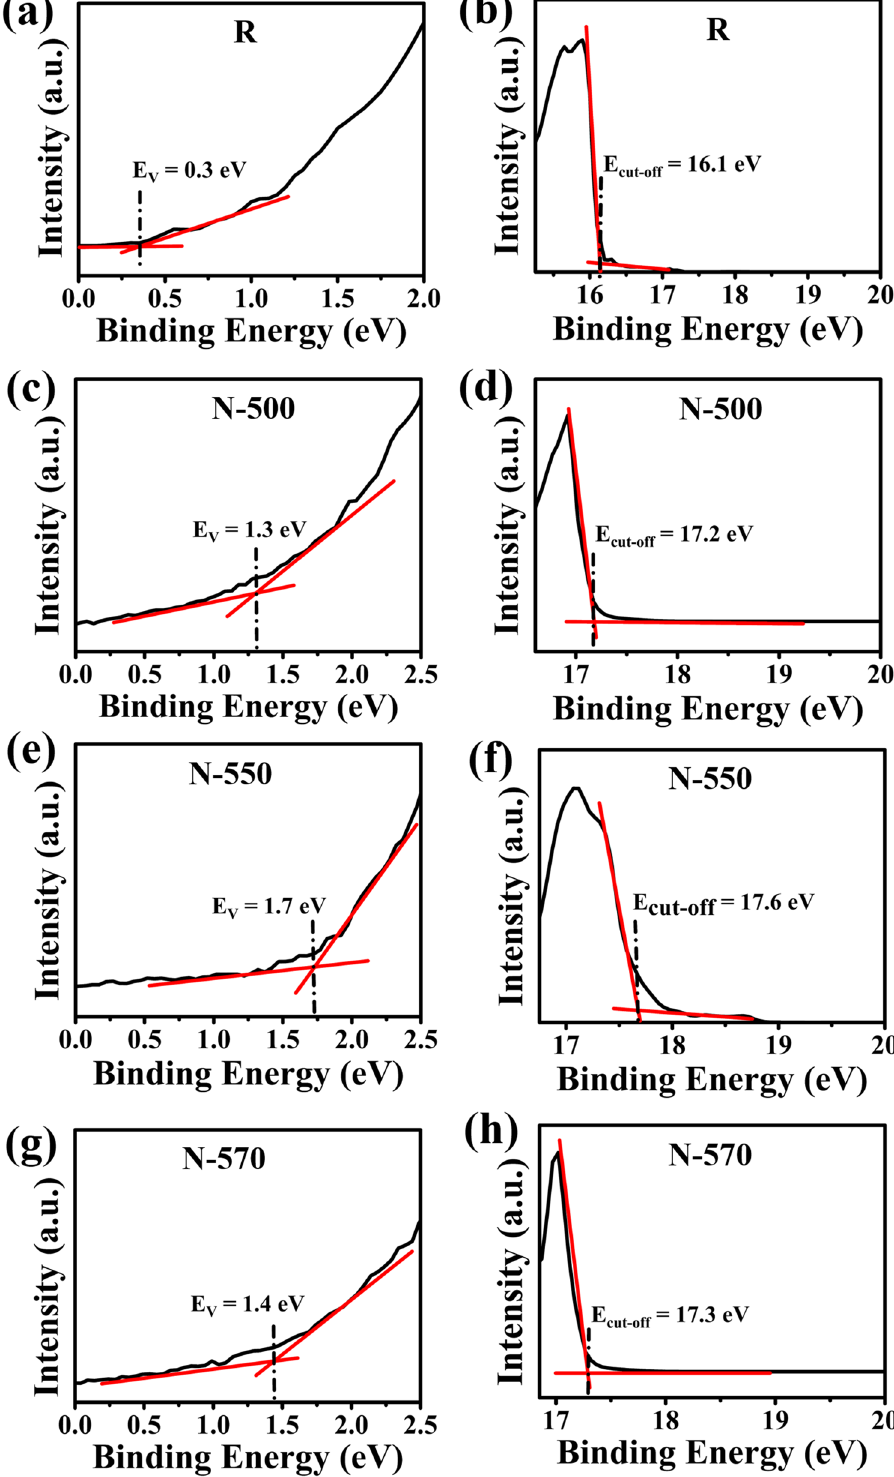
Figure 3. ( a , c , e , g ) Low-BE slope and ( b , d , f , h ) high-BE slope of the UPS spectra of R, N-500, N-550, and N-570 samples,